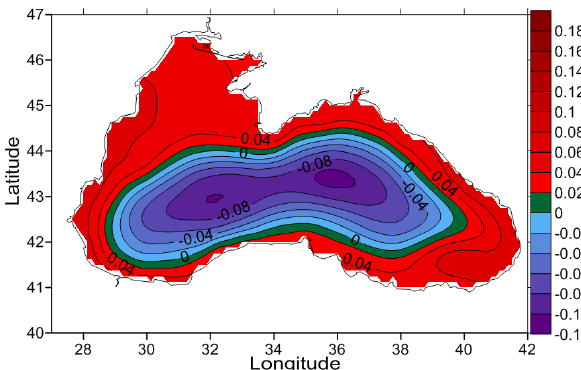
Fig. 2. Mean topography (averaged for 1973–1992) calculated by dynamic model with assimilation of climatic data (Knysh et al.,